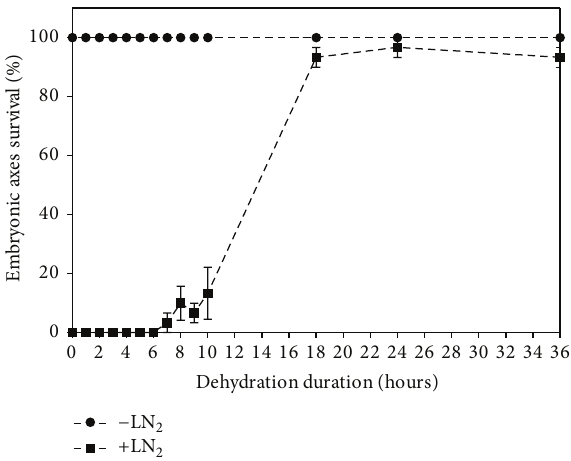
Figure 3: Viability of Genipa americana L. embryonic axes after desiccation and/or cryopreservation. Embryos were excised from seeds desiccated to different water contents ( e , − LN 2 ) or seeds that were desiccated and subsequently cryopreserved overnight (918 hours) in liquid nitrogen ( ◼ , +LN 2 ). Germination data was analyzed using analysis of variance (Two-Way ANOVA); mean comparison was carried out using Bonferroni test. 𝑃 value < 0.0001. Bars represent